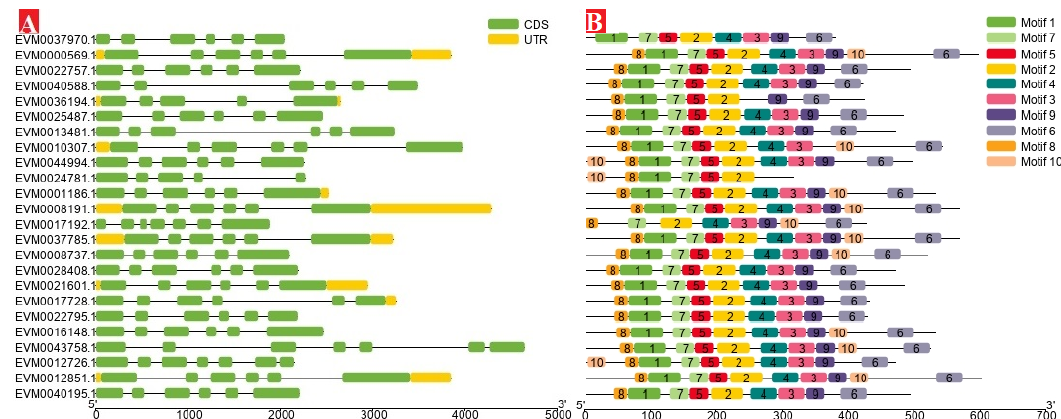
Figure 4. ( A ) Gene organization of EjALMTs . Color codes: Green–exons; black–introns; yellow–Untranslated Regions (UTR). ( B ) Conserved motifs identified by MEME tools.